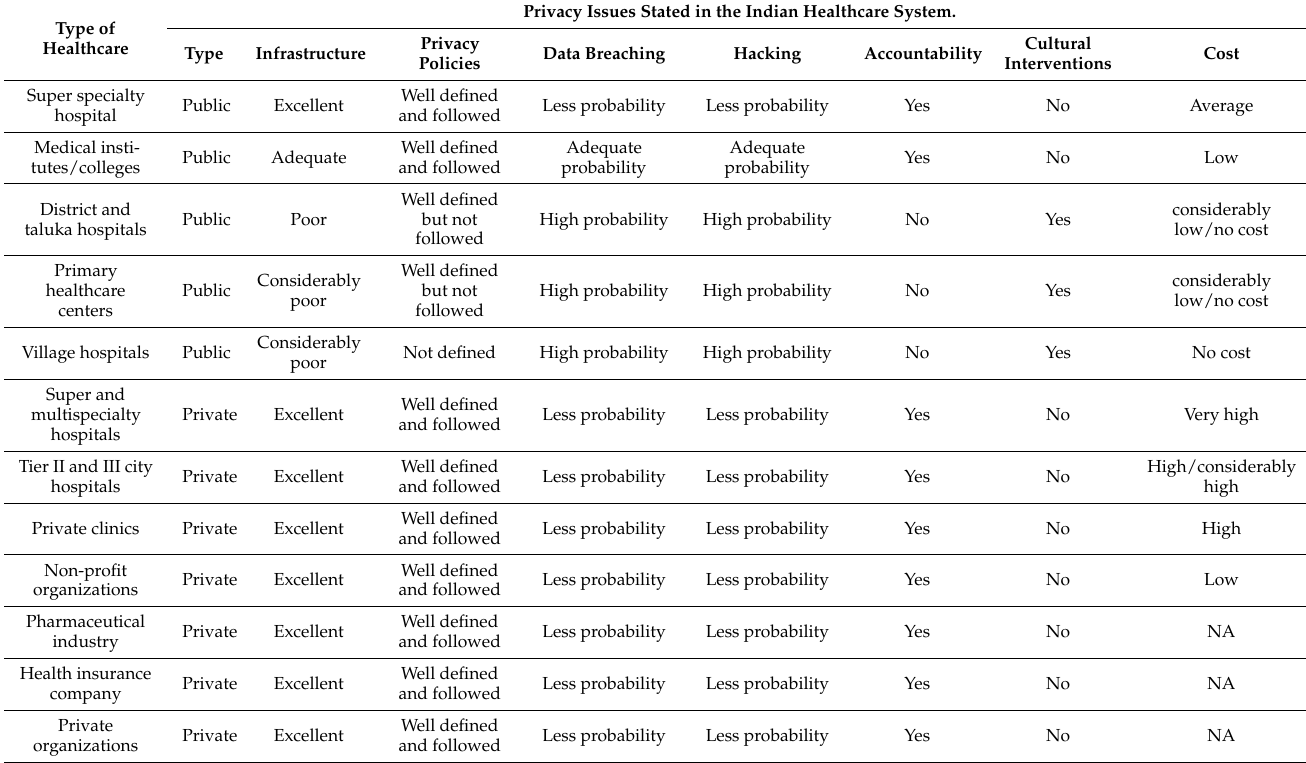
Table 10. Privacy issues stated in the Indian healthcare system